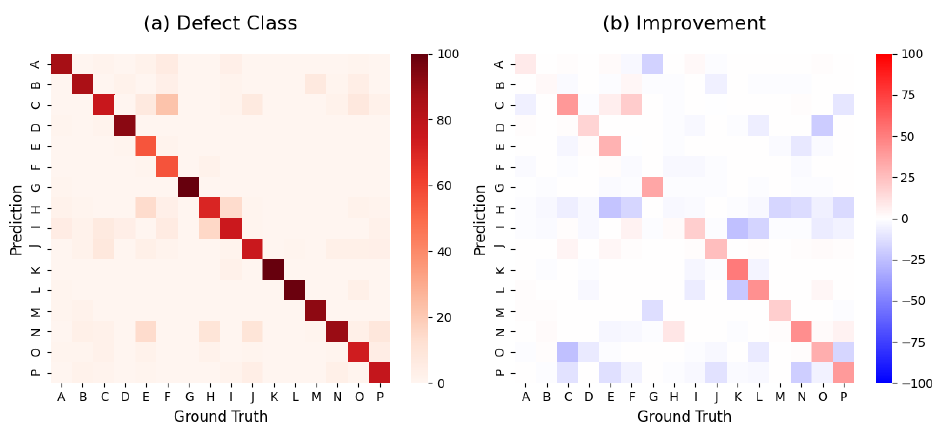
Figure 16. ( a ) Confusion matrix for the defect type segmentation task using the multi-branch model with process parameters. The first chart shows that the accuracy has improved over the model without the process parameters in Figure 13. ( b ) Improvement compared to the model without the process parameters. Most of the classes’ accuracy has been significantly